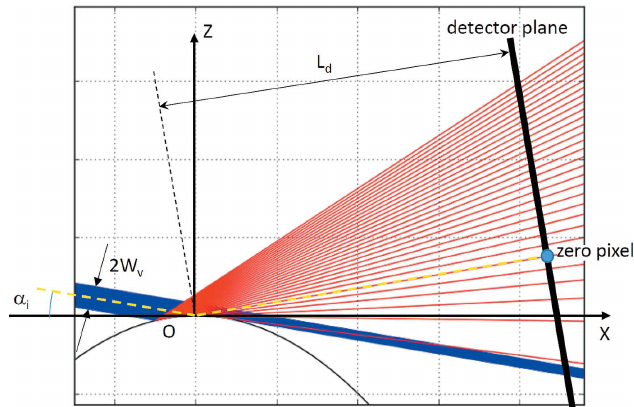
Figure 2 Scattering of the collimated X-ray beam on a cylindrical surface of radius R . The incident beam, coming from the left side, propagates in the plane XOZ normal to the cylinder axis that is perpendicular to the figure plane. A segment on the left side of the picture represents the detector plane, which is normal to the XOZ plane. ‘Zero pixel’ shows the position of the reflected beam from the cylinder apex. ‘Zero pixel’ is the origin of the coordinate system on the detector plane.